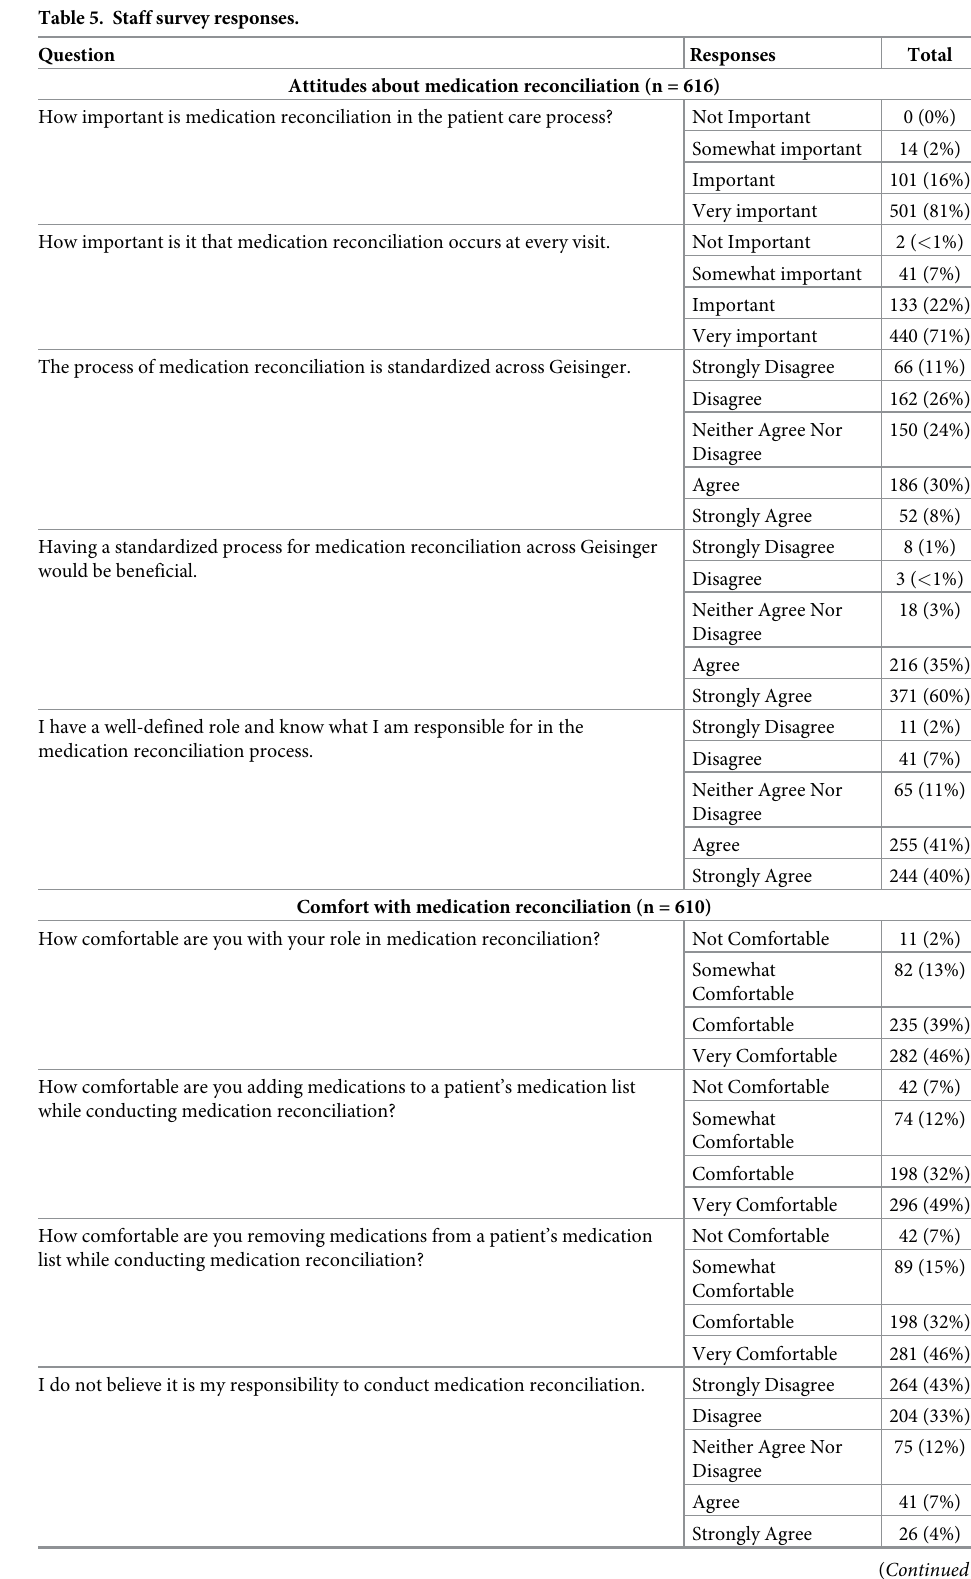
Table 5. Staff survey